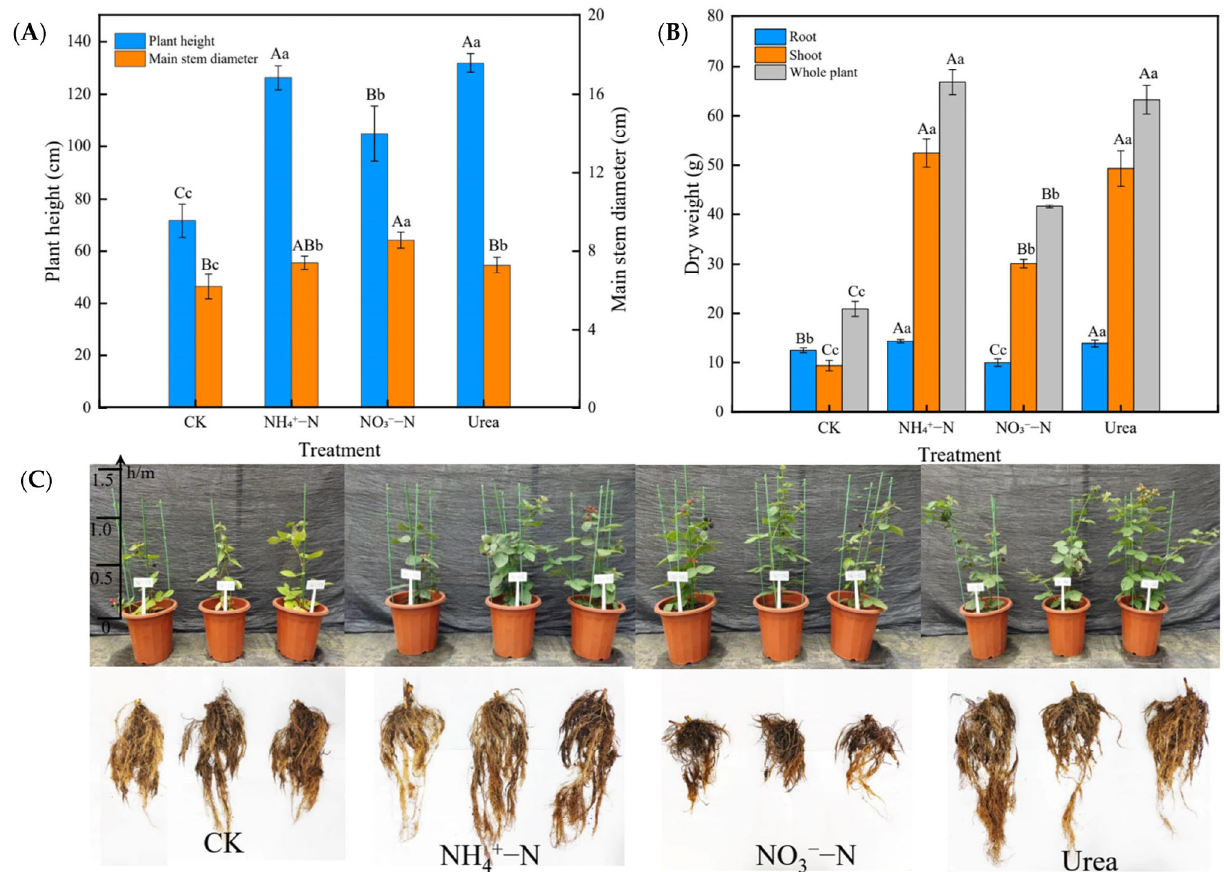
Figure 1. ( A ) Plant height and main stem diameter in response to different N forms. ( B ) The dry weights of the roots, shoots and whole plants in response to different N forms. ( C ) Phenotypes of the above- and below-ground parts of blackberry after 60 days of treatment with different N forms. Different letters show significant differences between treatments (uppercase letters indicate p < 0.01, lowercase le tt ers indicate p < 0.05).